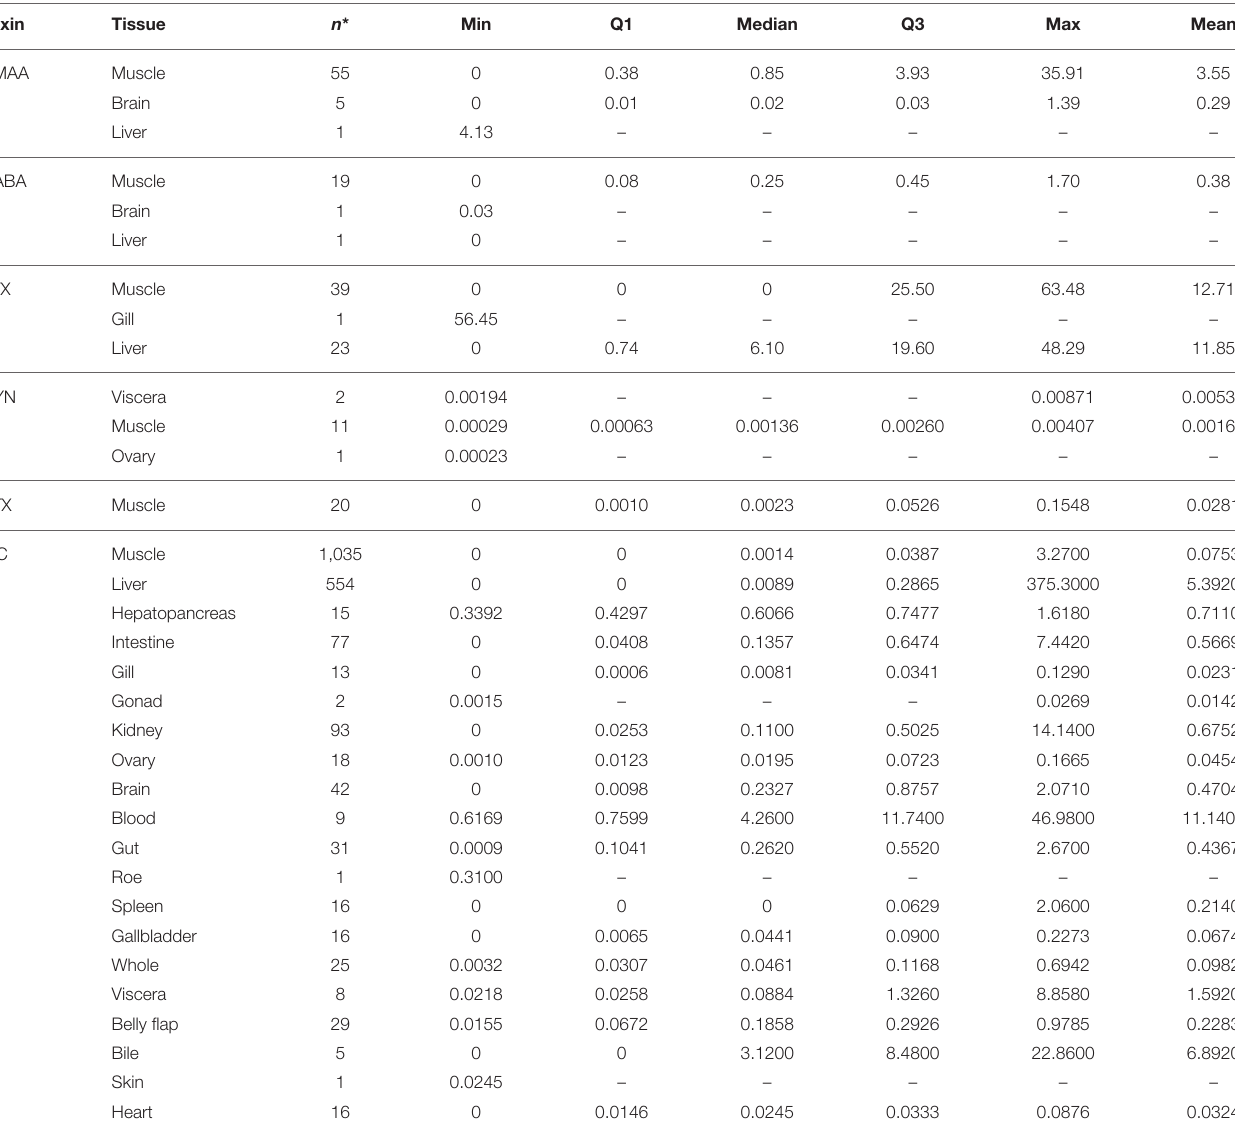
TABLE 2 | Descriptive statistics for concentrations ( µ g/g DW) of each cyanotoxin class in wild, freshwater fish tissues, including the sample size ( n ), minimum value reported (min), first and third quartiles (Q1 and Q3, correspondingly), median, and the maximum (max) and mean values.